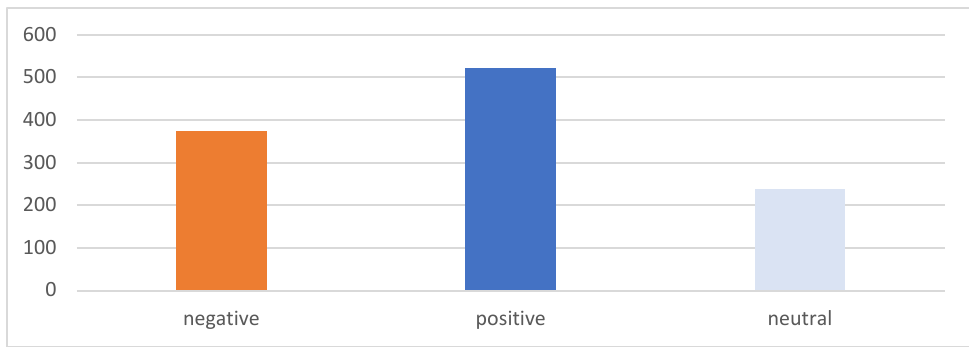
Figure 2. Distribution of sentiment score in the baseline dataset.